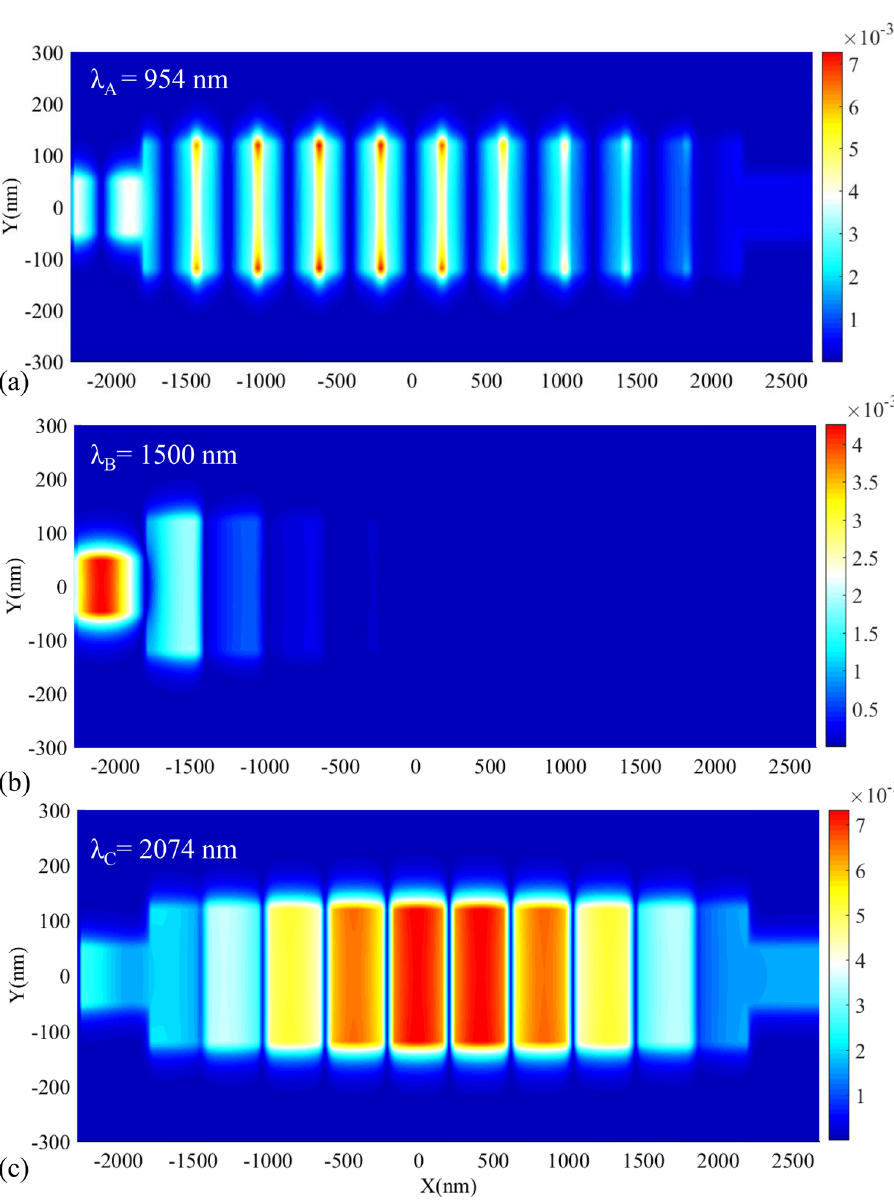
Figure 6. Field profile of | H z | for the proposed biosensor I at the wavelength of ( a ) λ A , ( b ) λ B , ( c ) λ C